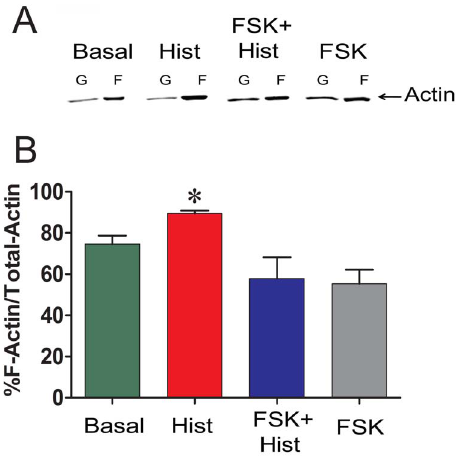
Figure 3. Preincubation with forskolin does not abolish histamine-induced increases in MLC phosphorylation. PCA rings were suspended in a muscle bath and equilibrated in Kreb’s bicarbonate buffer for 2 h. Rings were treated with either basal conditions, 5 m M histamine for 3 min, 5 m M forskolin for 10 min followed by 5 m M histamine for 3 min, or 5 m M forskolin for 10 min and snap frozen. Proteins were extracted and loaded on urea glycerol gels to separate the p-MLC and np-MLC and were detected by western blotting using an antibody that recognizes both forms. Panel A: Representative western blot of p-MLC and np-MLC. Panel B: Cumulative data representing the relative amounts of the p-MLC over the total MLC obtained when the phosphorylated and non-phosphorylated bands were quantitated densitometrically n=4. *significance between Hista- mine and Basal. # significance between Forskolin plusHistamine and Basal.